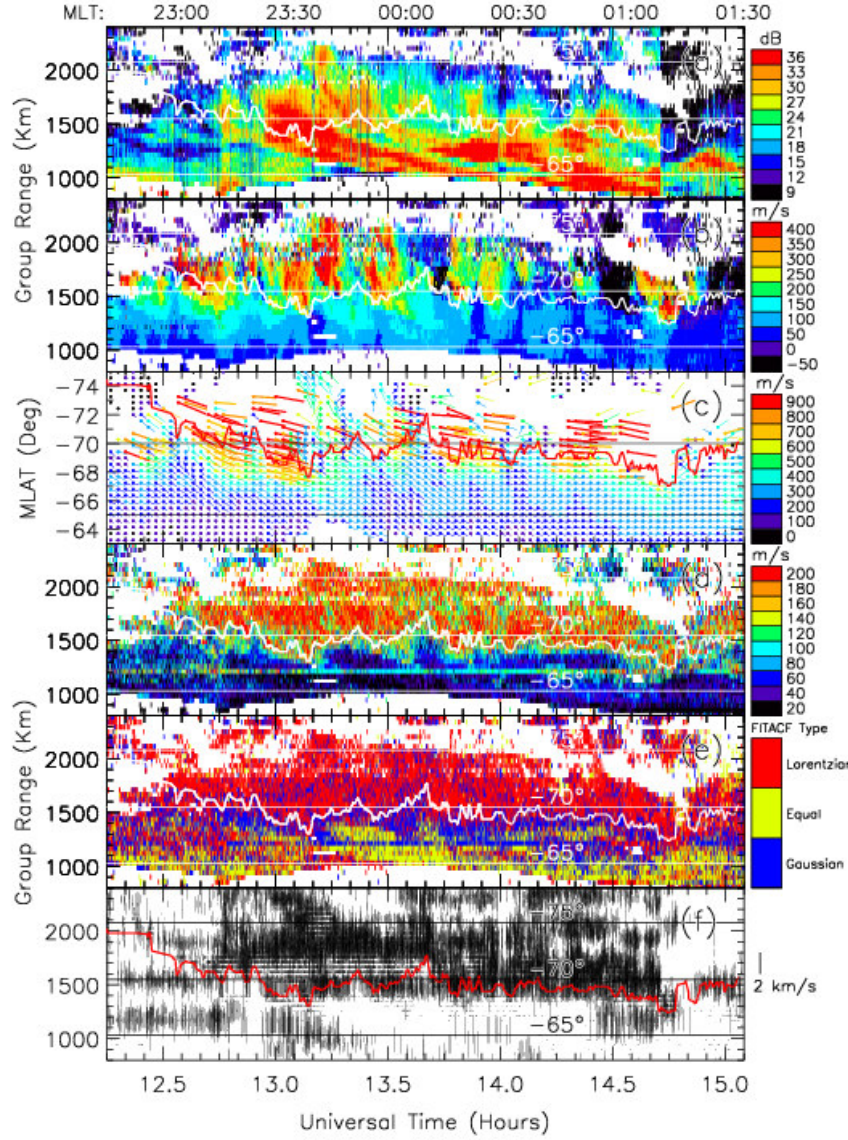
Fig. 1. All six panels show range-time plots of results calculated using TIGER Tasmania observations recorded at frequency 11.9MHz on beam 4 during 12:15 to 15:00UT on 10 December 1999. The three thin, horizontal lines in all panels represent corrected geomagnetic latitudes of − 65 ◦ , − 70 ◦ , and − 75 ◦ . The SWB has been superimposed in all panels (the bold, fluctuating curve near magnetic latitude − 1 ) . (c) 2-D beam-swinging vectors − 69 ◦ ). (a) FITACF backscatter power (SNR, dB). (b) FITACF line-of-sight Doppler velocity, v LOS (ms estimated using v LOS recorded on all 16 beams. The solid dots correspond to the time and latitude of the velocity estimate, and the flows are in the direction of the lines leaving the dots. The magnitude of the flows are indicated by the colour bar. (d) FITACF spectral width assuming a single peak (ms − 1 ) . (e) The FITACF spectral shape, Gaussian or Lorentzian, which gave the smallest fit error (see the text for an explanation). (f) The occurrence of doubled-peaked spectra identified using the Burg analysis. The length of the vertical lines indicate the separation between the two main peaks using a scale of 10ms − 1 km − 1